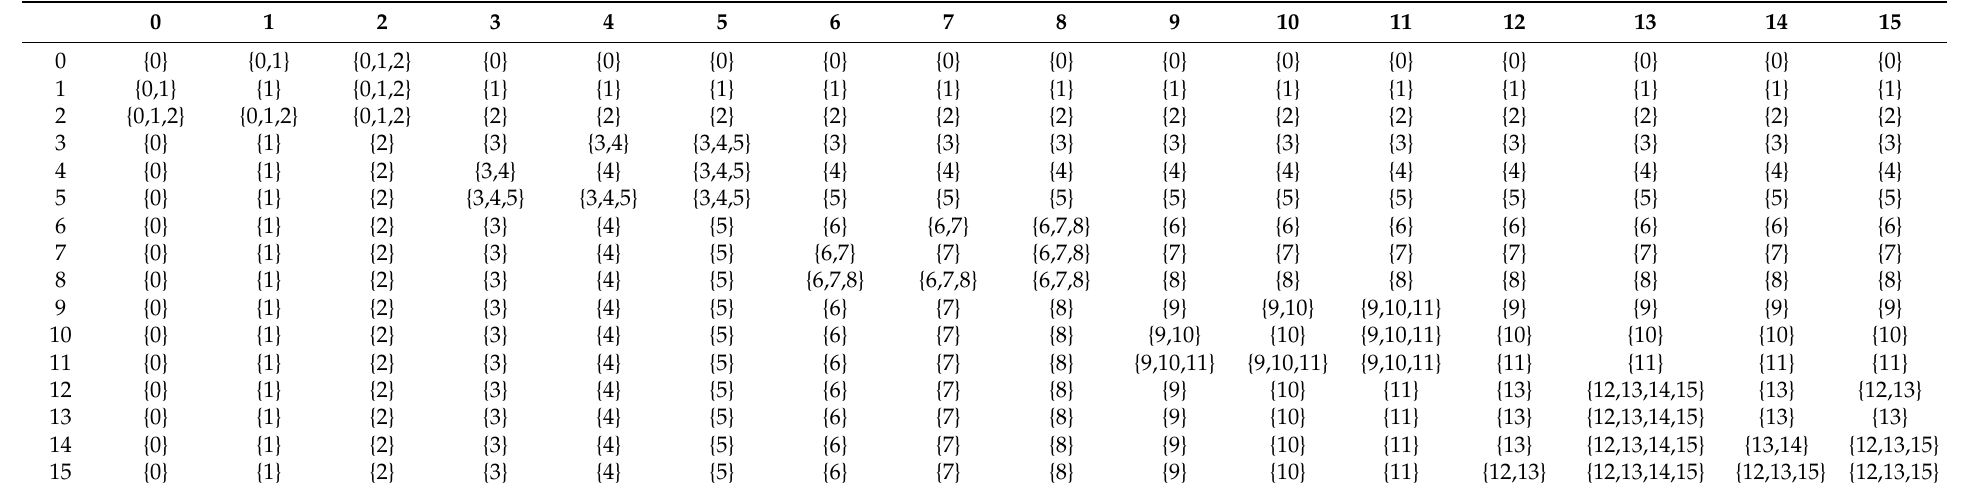
Table 13. CA-semihypergroup of order